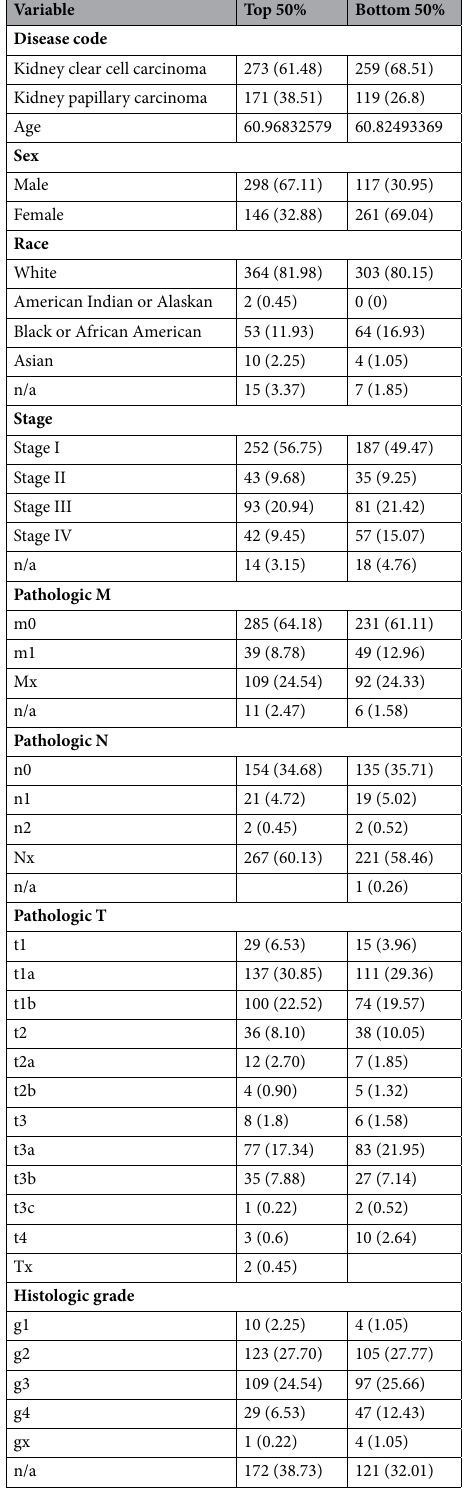
Table 1. Clinical characteristics of the top and bottom HAVCR1 (KIM-1) mRNA expressing patients in the KIRC and KIRP TCGA